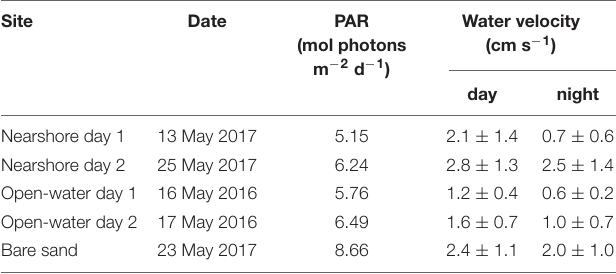
TABLE 1 | Environmental conditions during oxygen flux measurements including integrated photosynthetically active radiation (PAR) and day/night water velocities ( ± s.d.) measured above the habitat of